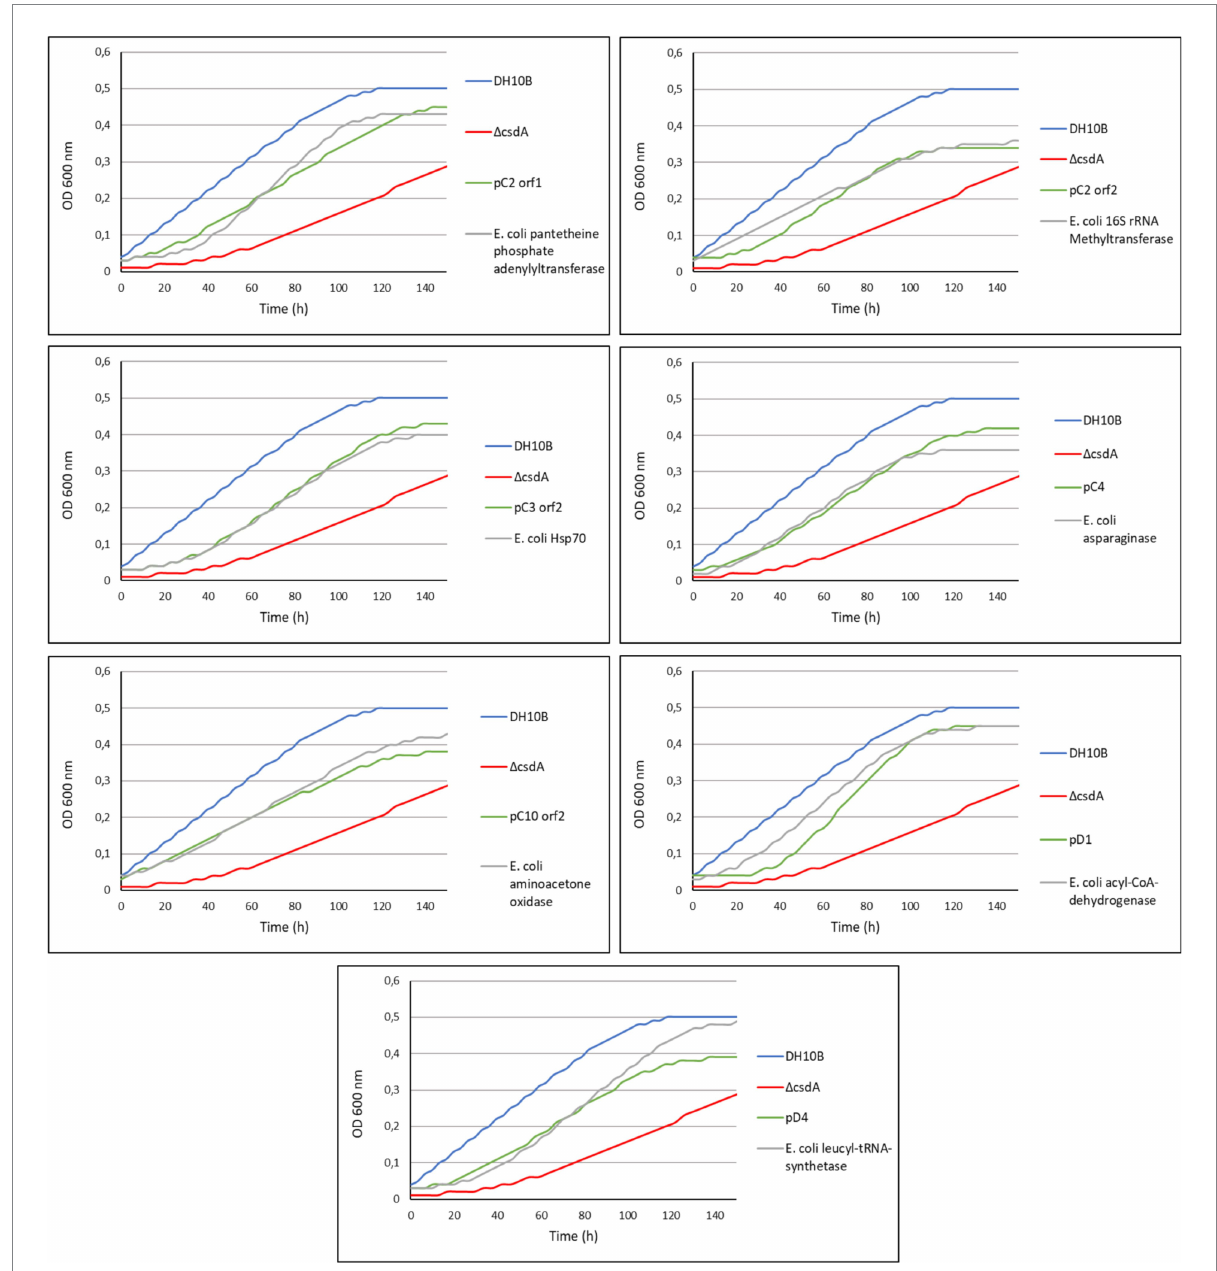
FIGURE 5 Comparison of the growth curves of some of the cold-tolerant genes characterized in this study and their homologous genes in E. coli . DH10B strain carrying an empty pBluescript vector was used as a positive control and the single cold-sensitive mutant (DH10B Δ csdA ) also carrying an empty pBluescript vector was used as a negative control. All clones were grown during 5 h at 37 ° C with a slight agitation and then their OD 600 nm values were adjusted to 0.03. They were grown in 96-well microtiter plates during 140 h at 15 ° C with a slight agitation (80 rpm) and OD measures were taken in the SPECTROstar Nano (BMG Labtech) four times per day. Six replicates per clone were introduced in each assay and each experiment was repeated at least three times using independent cultures to corroborate the